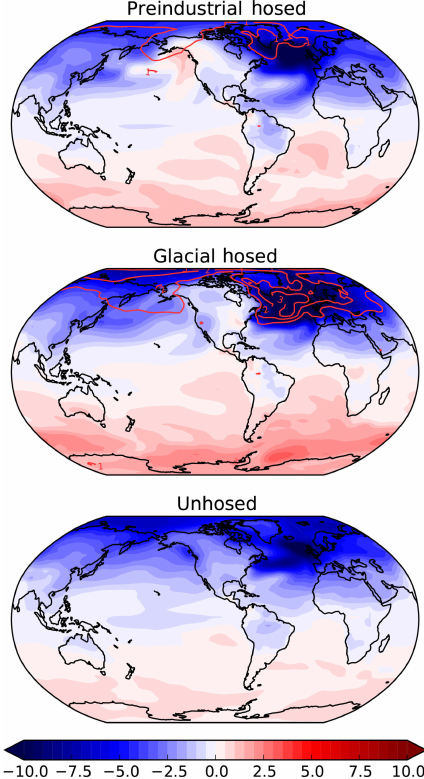
Figure 7. Stadial precipitation anomaly. The top two panels show the precipitation difference between weak and strong AMOC states (as defined in Fig. 3) under preindustrial and glacial boundary con- ditions, averaged between the four sets of orbital configurations (see Fig. S4 to view all eight hosing simulations individually). Red con- tours show the standard deviation between the four sets of orbital configurations at 5 × 10 − 6 kgm − 2 s − 1 intervals. The bottom panel shows the precipitation difference between weak and strong AMOC states (as defined in Fig. 3) in the unhosed simulation. Shading and contours in 10 − 6 kgm − 2 s − 1